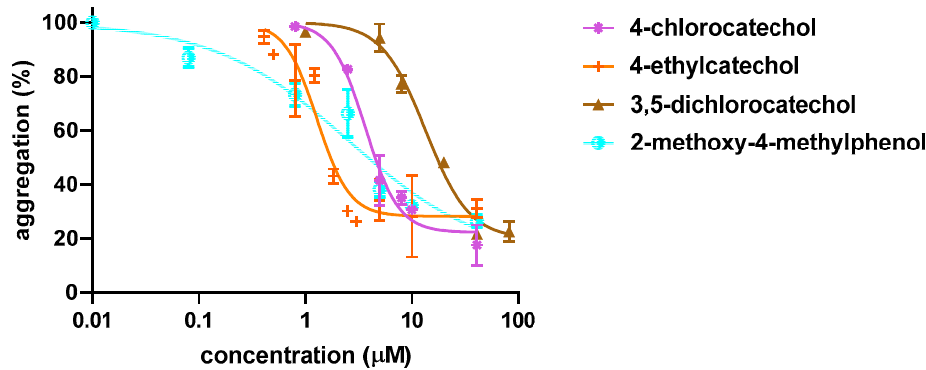
Figure 2. Examples of Dose–response Curves in Arachidonic Acid-triggered Platelet Aggregation. Four compounds with different potencies were intentionally selected. Results show the summary of three independent experiments. Curves were fitted using a non-linear regression method. Table 1. IC 50 on Arachidonic Acid-induced Platelet Aggregation.